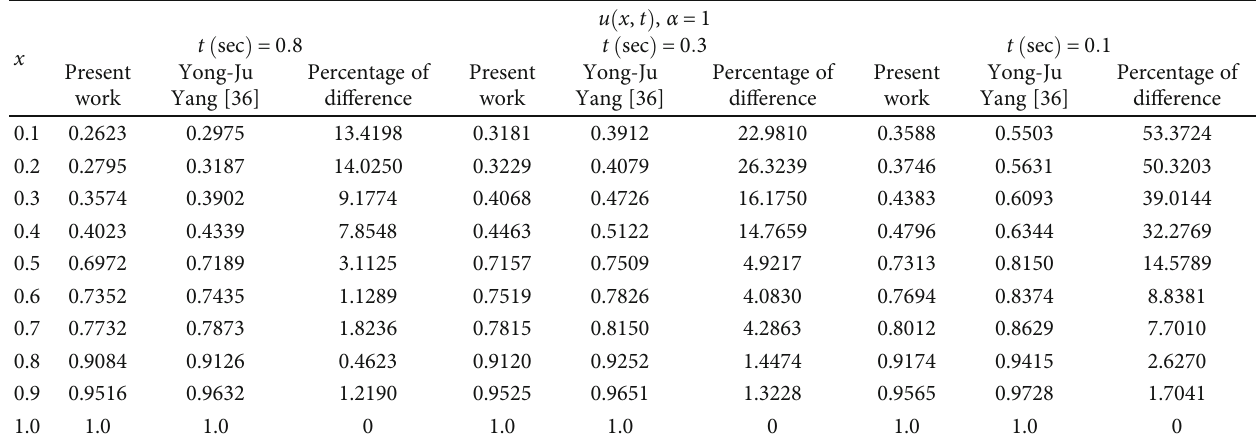
Table 1: The variation of u ð x , t Þ versus x with α = 1 , t = 0 : 1, 0 : 3, and0 : 8 sec :